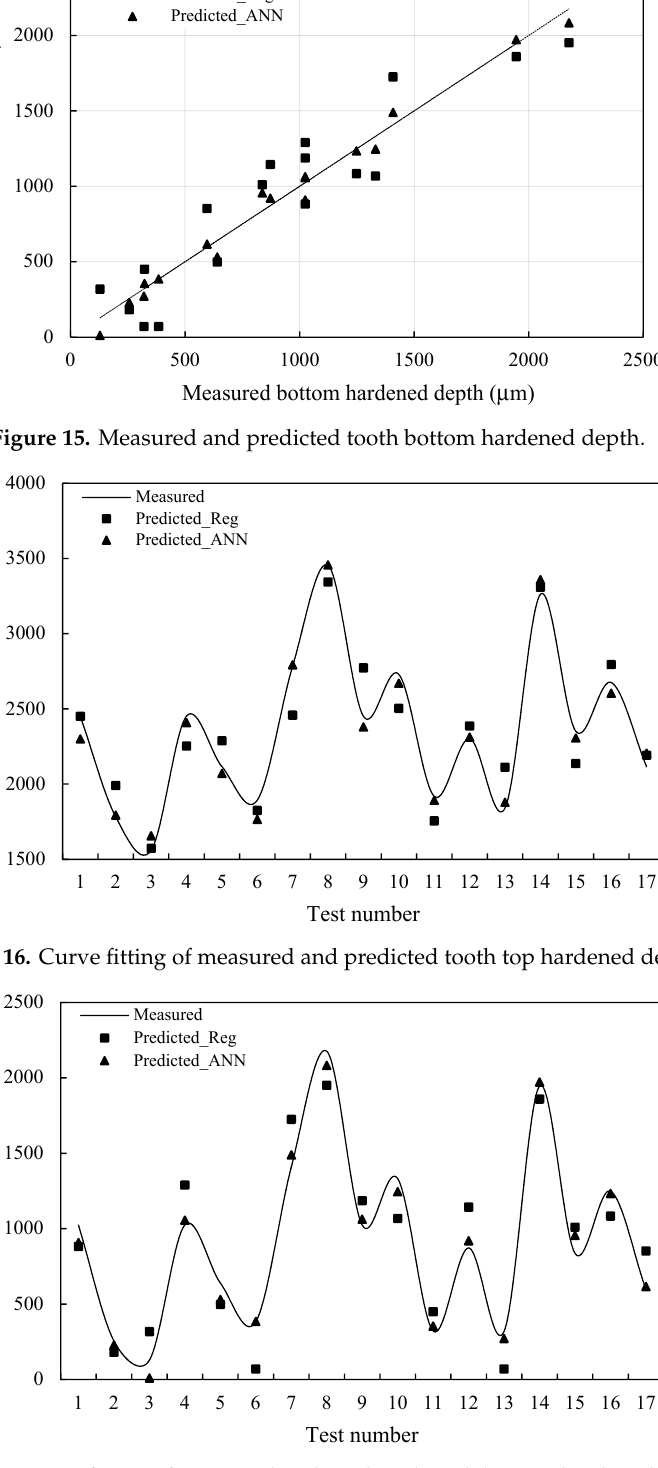
Figure 17. Curve fitting of measured and predicted tooth bottom hardened depth.